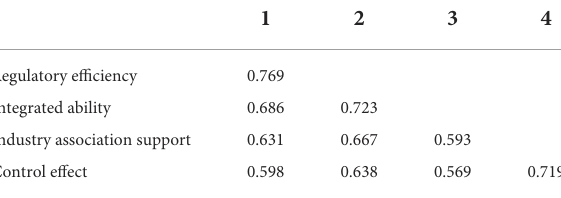
TABLE 5 Mean, variance and square root of AVE for latent variables.